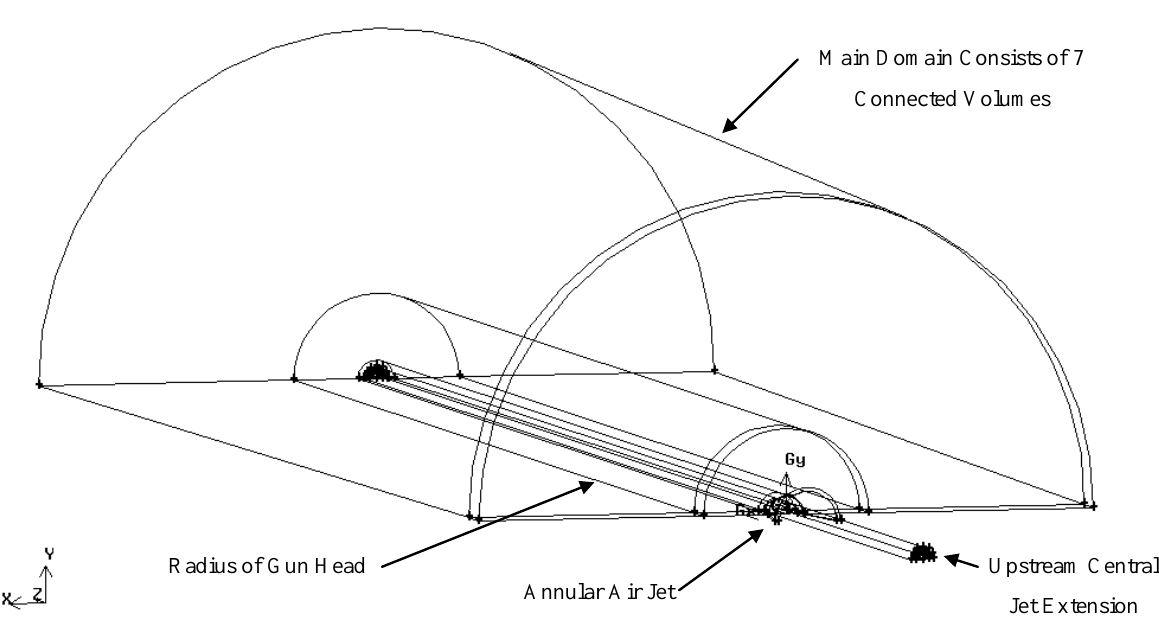
Figure 10. Flow domain for Grid 4 (the semi-circular case).